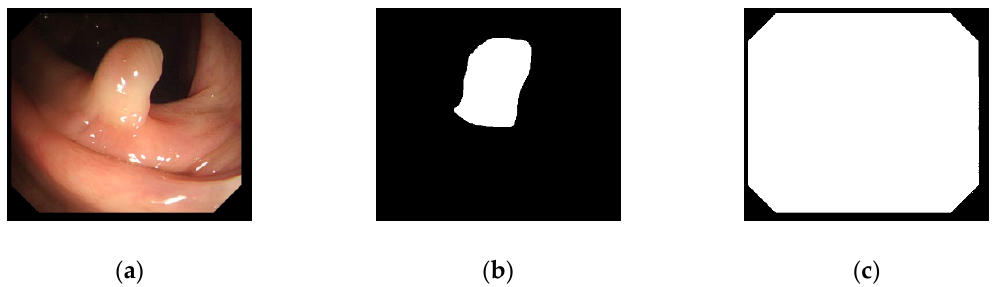
Figure 1. Example of the CVC-EndoSceneStill dataset ( a ) polyp image; ( b ) polyp binary mask; ( c ) void binary mask.